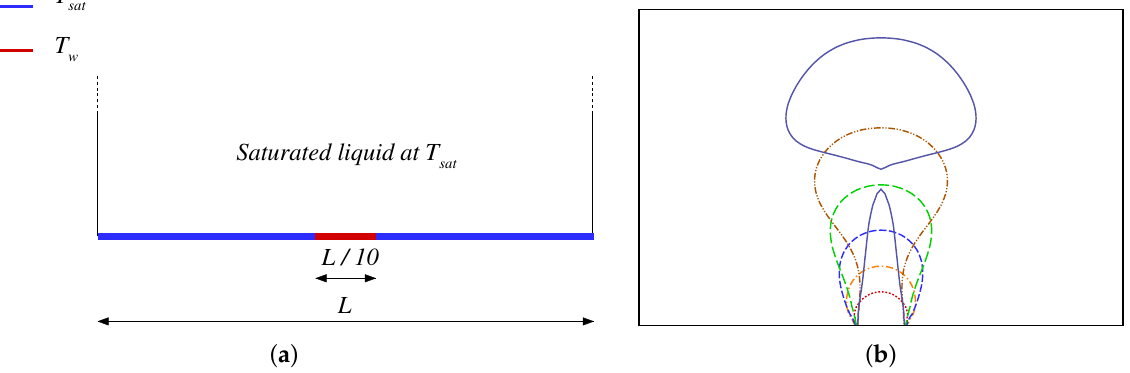
Figure 4. ( a ) Schematic of the nucleate problem. ( b ) The interface of the vapor bubble during the nucleation, starting from the appearance of the first nucleus until the release of the first bubble. From bottom to top; Fine-dashed: Time = 600, Dash dot: Time = 1200, Dashed: Time = 1800, Long-dashed: Time = 2400, Dash dot-dot: Time = 3000, Solid: Time = 3780. Times are measured in lattice